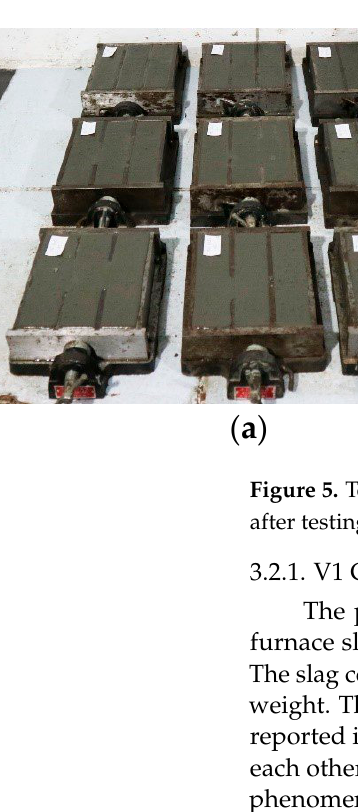
Table 6. Mixing time, flow, and compressive strength of V1